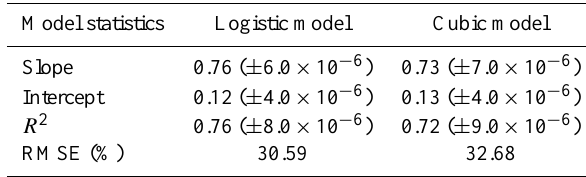
Table 3. Model performance comparison using regression analysis. The values given in the brackets are the standard error of the es- timates obtained by resampling evaluation data 10000 times. The root mean square error estimate from the measured and modeled values is also